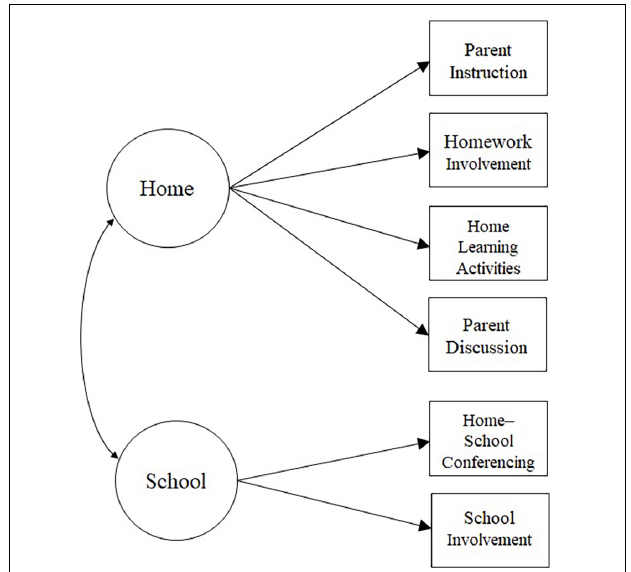
FIGURE 1 | Measurement